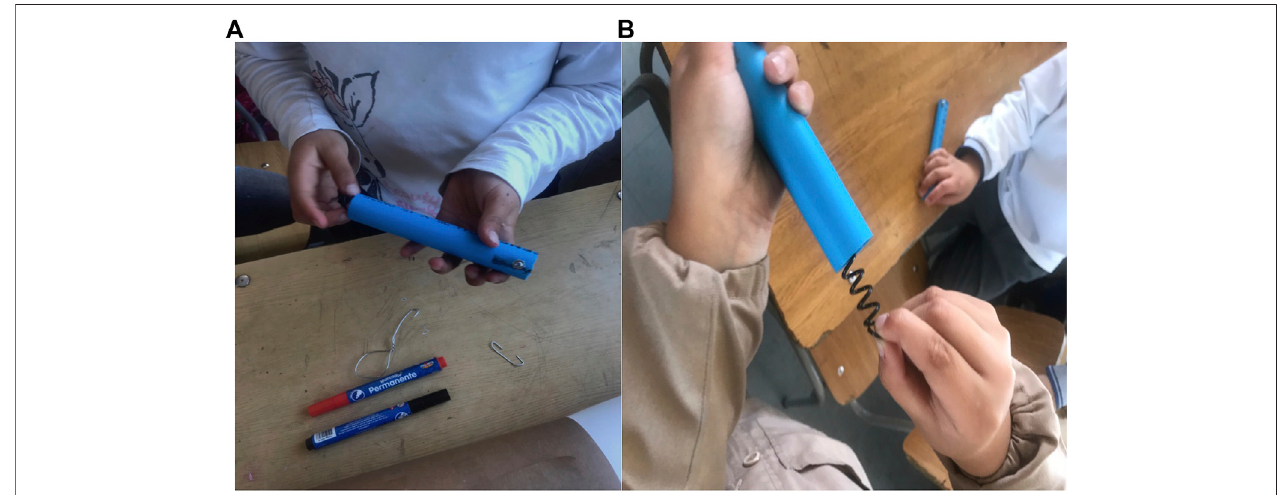
FIGURE 5 | (A) manual control and exploration; (B) object